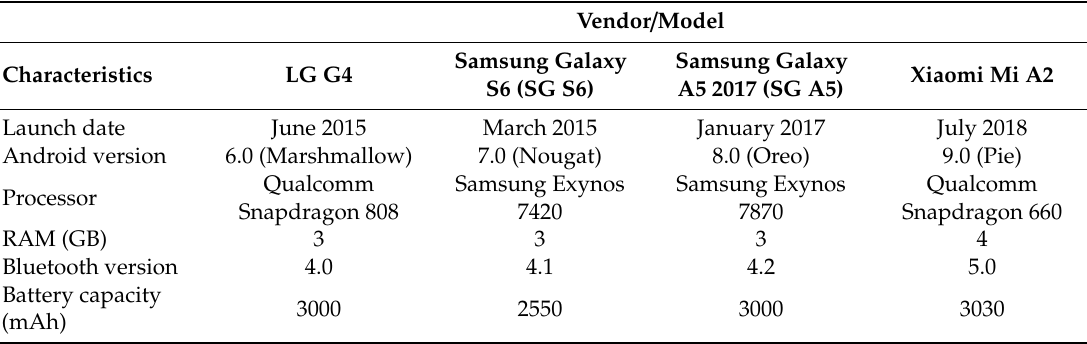
Table 1. Characteristics of the smartphones employed in the